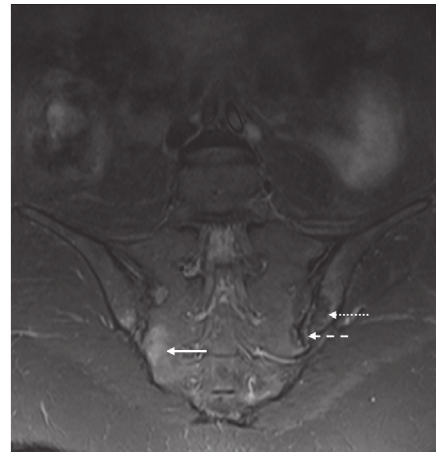
Figure 14: Sacroiliitis. Coronal STIR sequence of sacroiliac joints (SIJ) of a 34-year-old male with right acute on chronic and left chronic sacroiliitis. The region of the acute inflammatory process is denoted by the marrow oedema signal in the cartilaginous com- ponent of the right SIJ (arrow). Marrow fat infiltration (dotted arrow) adjacent to the left SIJ inferiorly implies prior inflammation. Irregular joint surface (dash) is consistent with